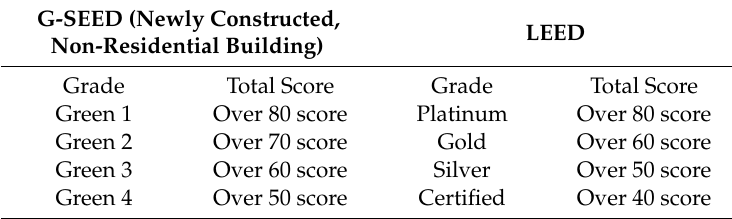
Table 1. Certification level and G-SEED and LEED scores.